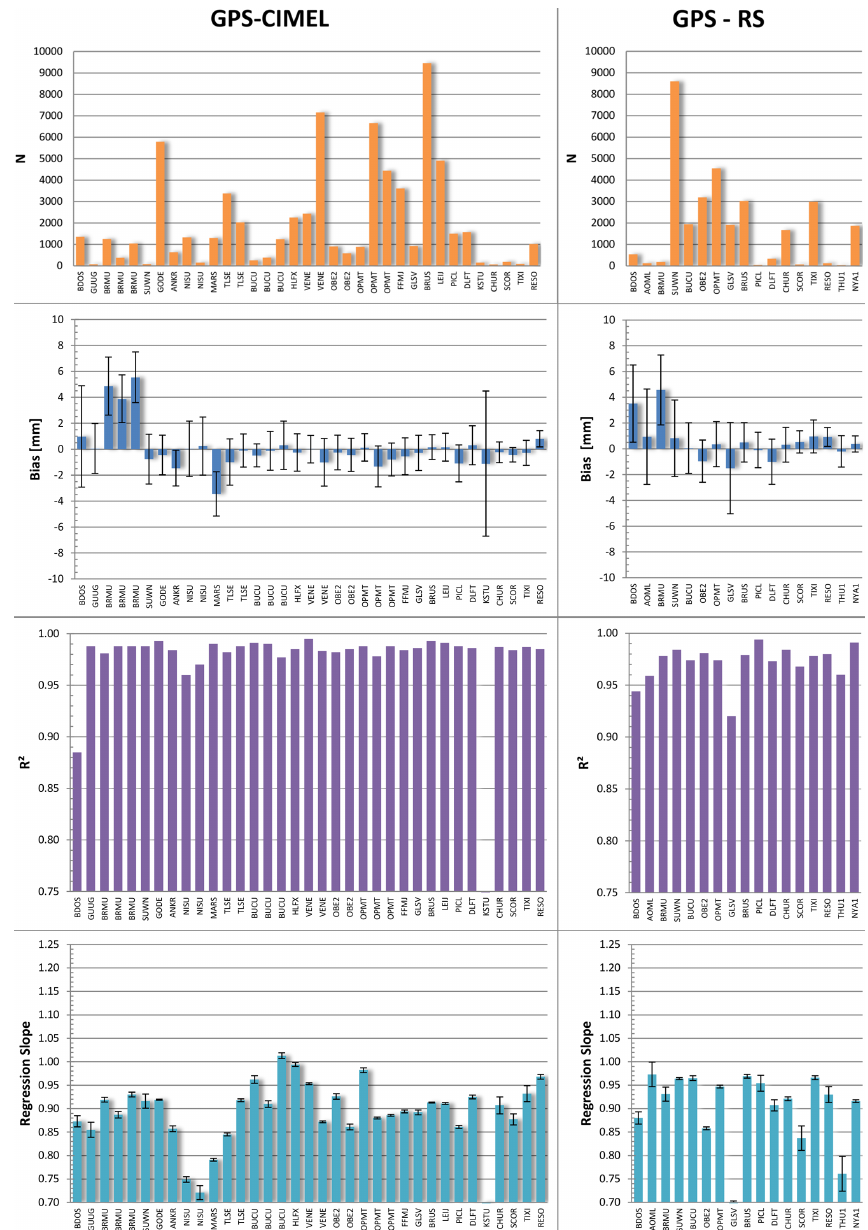
Figure 11. Column bar plots of scatter plot properties (count N , bias, R 2 and regression slope) of the different CIMEL and radiosonde instruments versus GPS for the selected sites. Sites are ordered with increasing latitude. The error bars represent the SD of the differences (bias panels) and the one-sigma uncertainty estimate of the regression